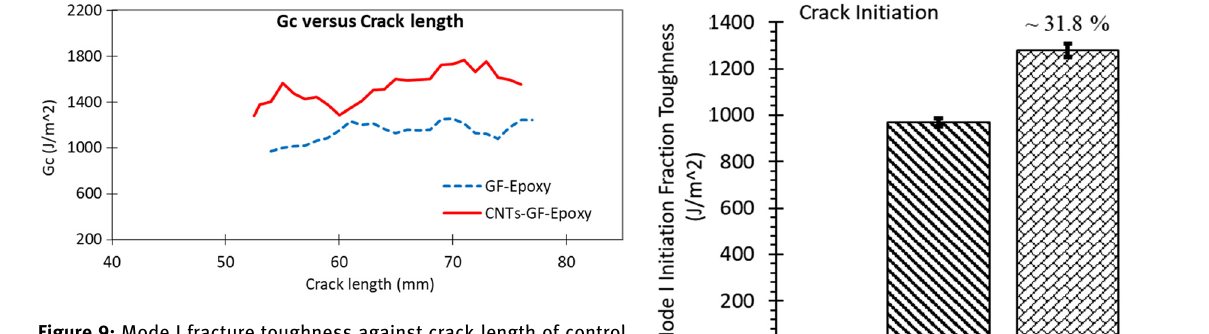
Figure 9: Mode I fracture toughness against crack length of control sample ( GF - Epoxy ) and hybrid sample ( CNTs - GF - Epoxy ) .